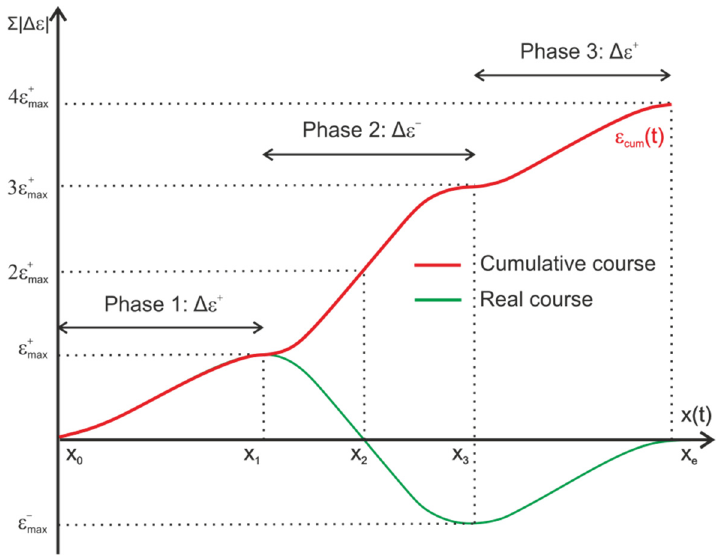
Figure 5. Difference between the actual deformation profile and the cumulative profile (own